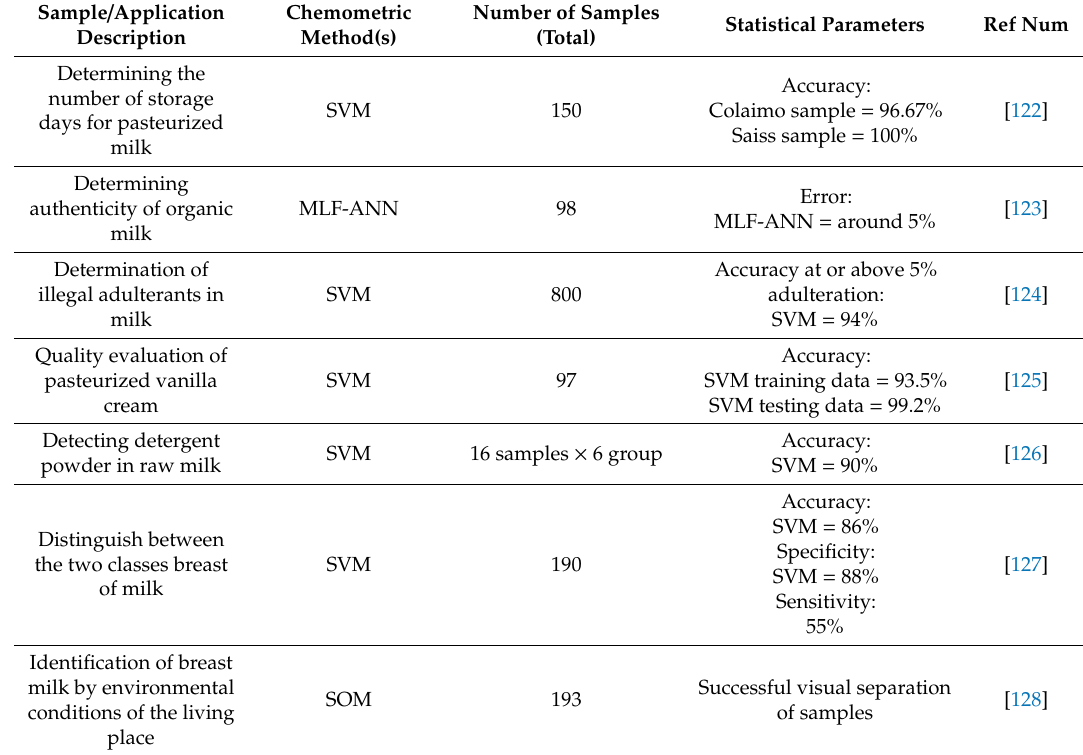
Table 6. Literature related to the use of chemometrics in classification of dairy